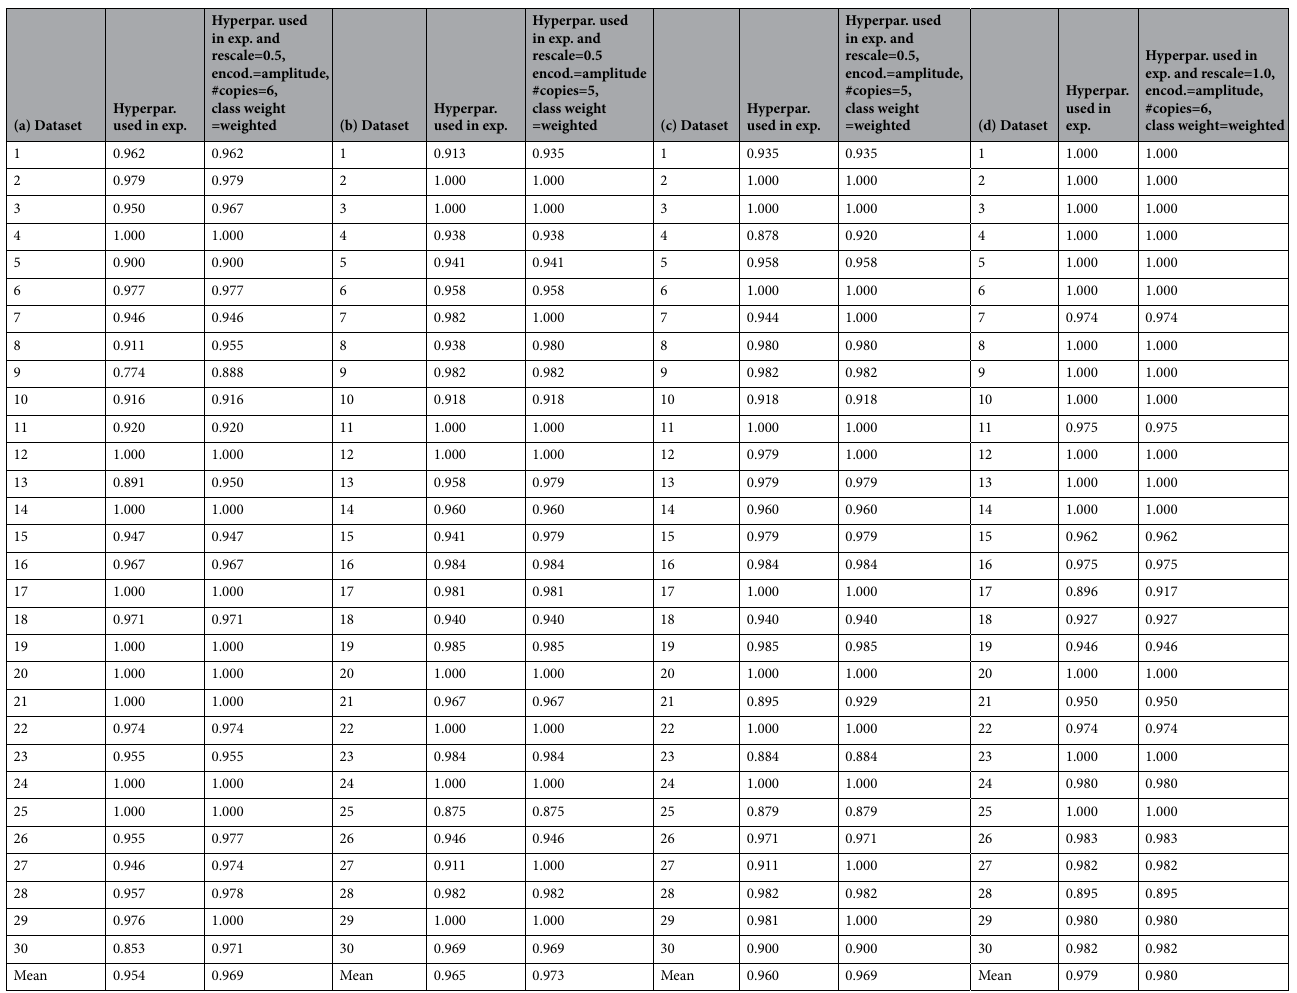
Table 3. Performance of HQC when increasing the number of copies by an addition of one copy for cases where HQC does not outperform the other classifiers. (a) For cell line MDA-MD-231, comparison of AUROC score for HQC when increasing the number of copies to 6 for 30 homogeneity image feature datasets. (b) For cell line MCF7, comparison of balance accuracy score for HQC when increasing the number of copies to